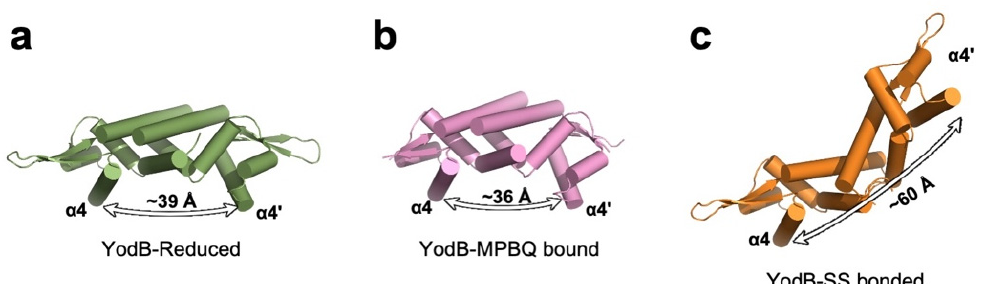
Figure 3. Distinct structural rearrangement of B. subtilis YodB upon S-alkylation and disulfide bond formation. The overall structure of YodB in the reduced state (panel ( a ); PDB ID: 5HS7), methyl- p -benzoquinone (MPBQ)-bound (panel ( b ); PDB ID: 5HS9) and with disulfide-bonds (panel ( c ); PDB ID: 5HS8), is shown. The distances between DNA major groove recognition helices ( α 4) in each dimer are shown.